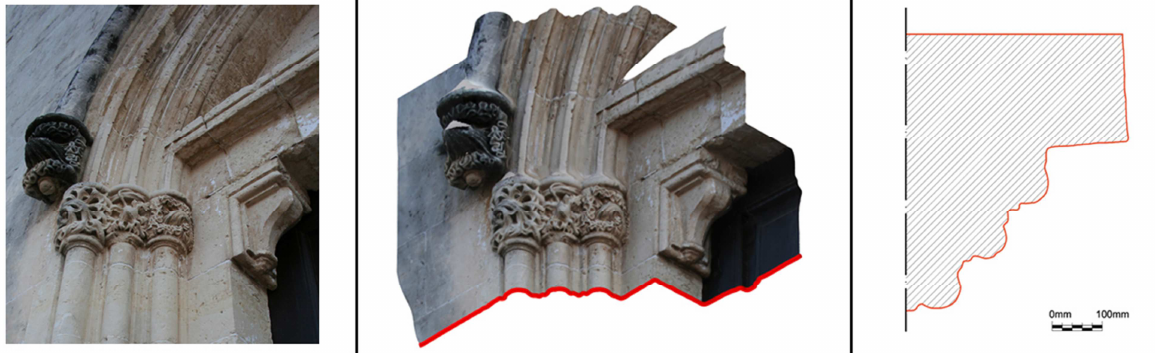
Figure 11. Portal of San Pietro, Assemini (Ca): photographic image; model 123D Catch; reconstruction of the flat section.